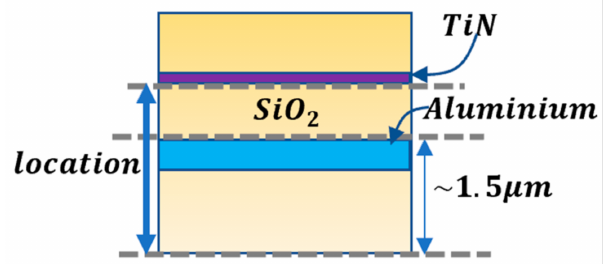
Figure 10. Schematic of the TiN location in the TMOS sensor.